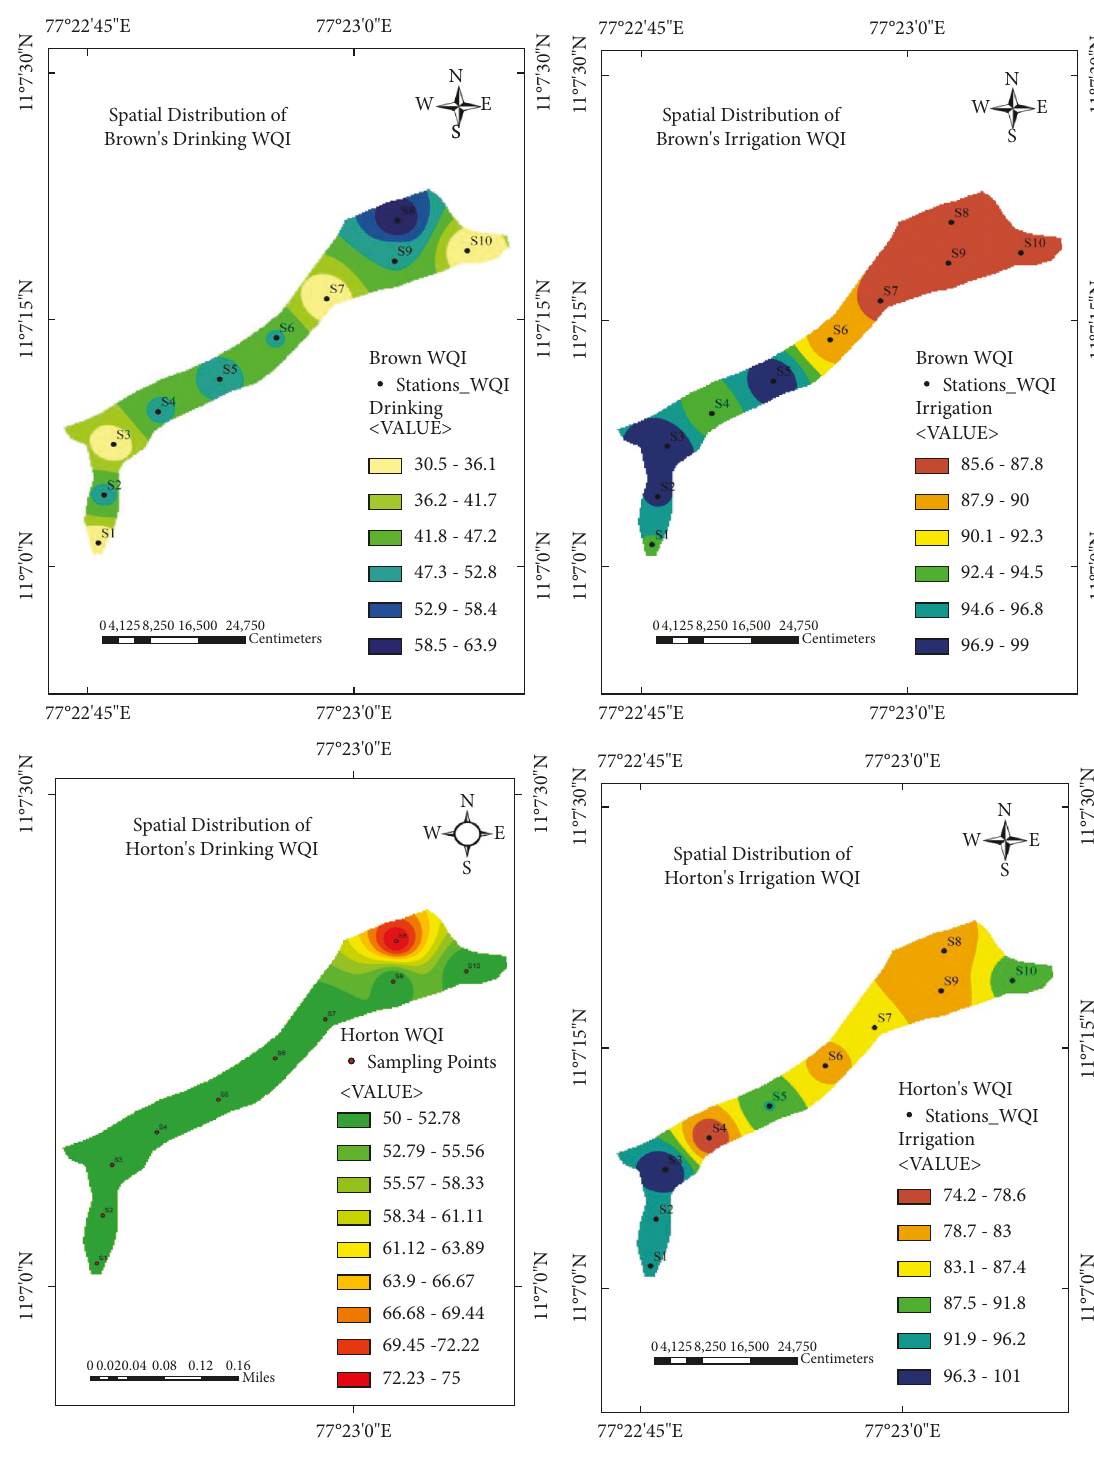
Figure 2: Spatial distribution of WQI for drinking and